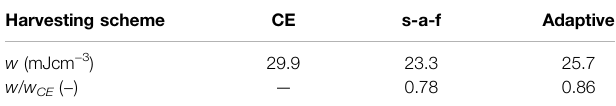
TABLE4| Energydensityharvestedata fi eldof50 Vµm − 1 foraninputdistribution of capacitance swing values following a normal distribution with μ = 2.75, and σ = 0.8. The constant fi eld (CE) value is a theoretical value, and the set-and-forget (s-a-f) and adaptive values are the experimental values obtained as the average of 200 cycles. The second line shows the relative energy density wrt the CE benchmark.